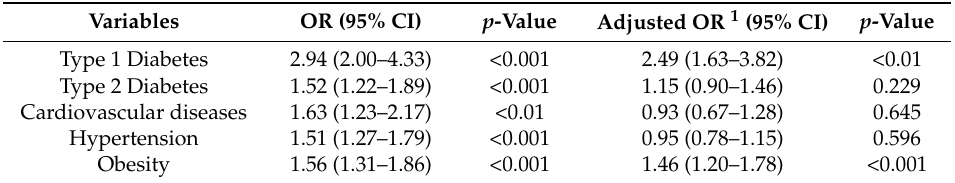
Table 2. Odds ratios (ORs) and 95% CIs of osteoporosis (AD-SoS T -score lower than − 3.2 SD) in presence of diabetes, cardiovascular diseases, hypertension, and obesity.